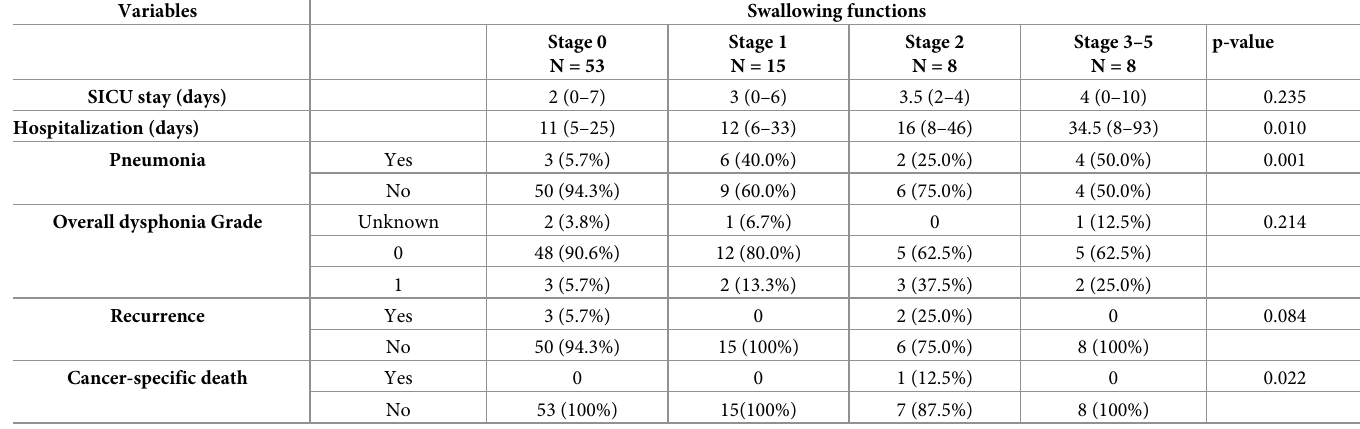
Table 4. Operative